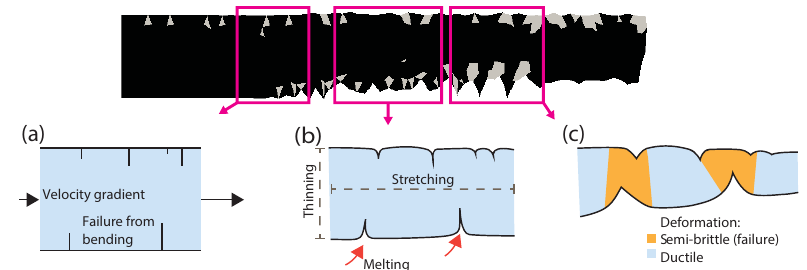
Figure 9. Schematic of how semi-brittle deformation could proceed in nature, through space and time. (a) Initial failure forms due to high strain rates as ice accelerates across the grounding line, with the added bending due to tidal motion. (b) Ice continues to accelerate as it floats without resistance into the ocean; (not simulated here) melting as hot, buoyant water enters cracks and erodes crack walls, widening and thinning the ice. (c) Ice reaching its terminal speed at the front undergoes both semi-brittle deformation and ductile deformation. Semi-brittle failure occurs where ice has previously failed (in thin spots) and further thins the floating tongue, while ice between surface cracks and bottom cracks undergoes ductile deformation. The geometry produced by these processes resembles boudins, which eventually calve into the